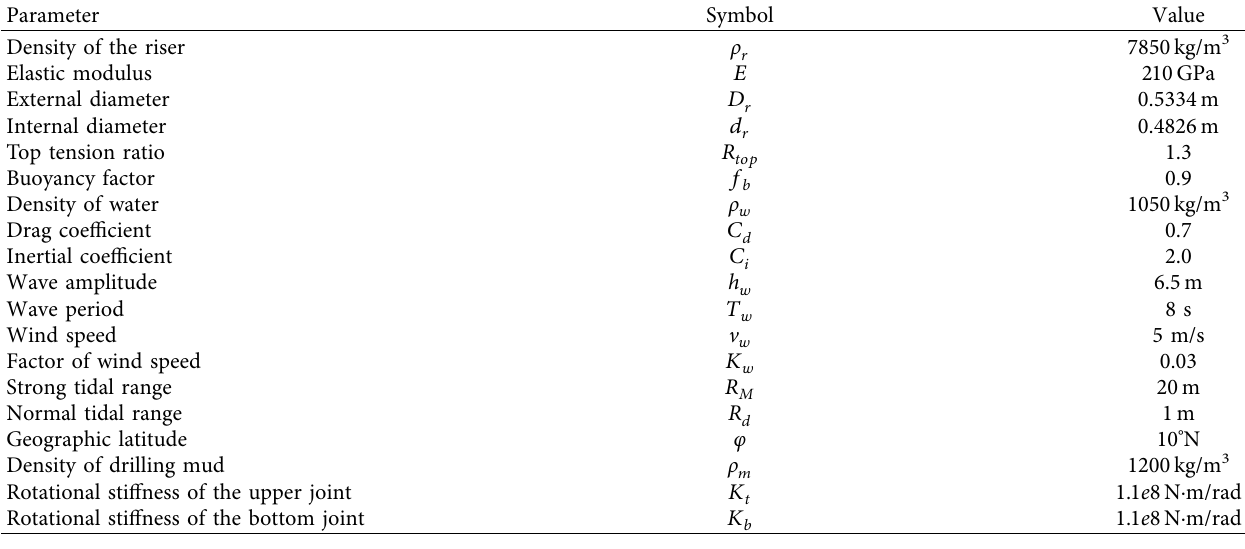
Table 1: System parameters for the dynamic analyses of the riser model.